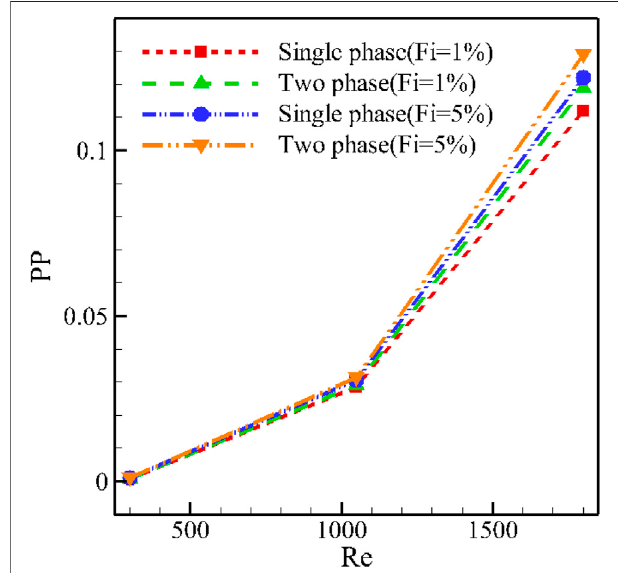
FIGURE 8 | H-S thermal resistance at different amounts of Re and two values φ for the T-P and S-P simulation models.